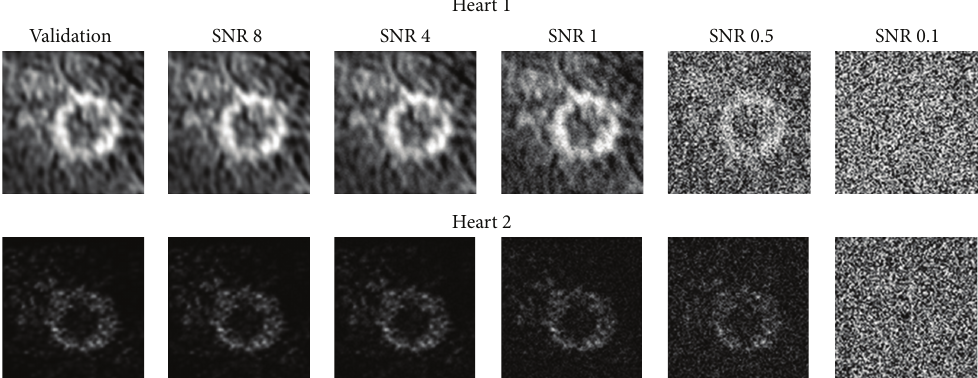
Figure 2: Mid ventricular slices of the image data sets used in the validation and SNR 8-SNR 0.1 analyses. The image data sets with an SNR of 0.1 demonstrate that there remains little or no image information of the LV in the images.